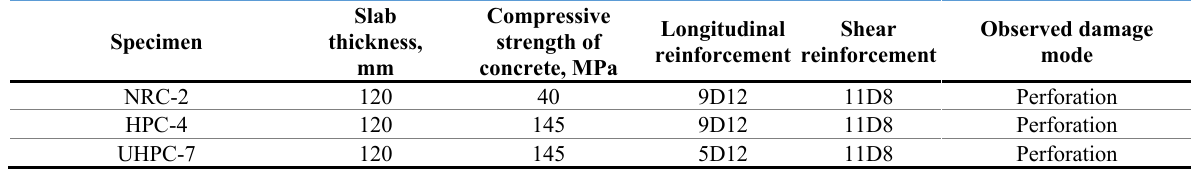
Table 1- . Summary of slab specimens tested by Li et a [10]